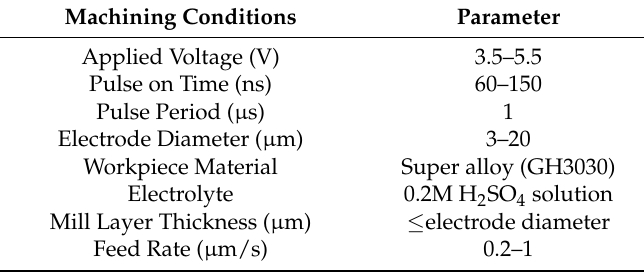
Table 1. Machining conditions for EMM experiments.